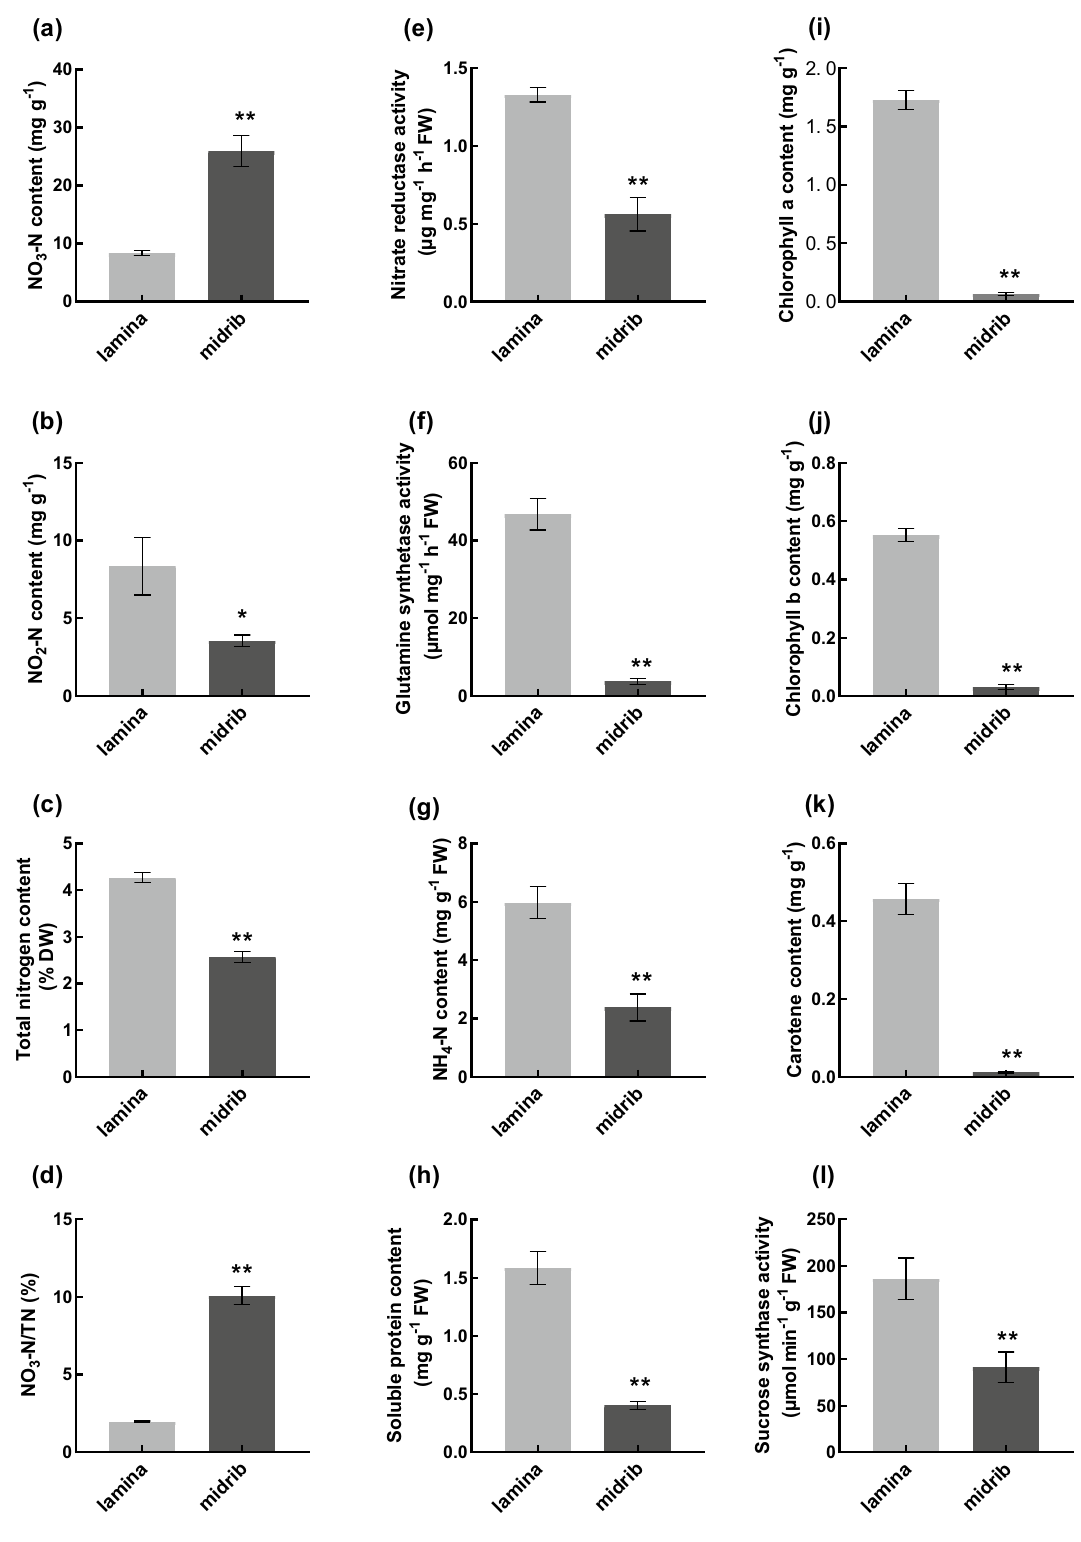
Figure 1. ( a ) NO 3 -N content; ( b ) NO 2 -N content; ( c ) total nitrogen content; ( d ) NO 3 -N/TN; ( e ) nitrate reductase activity; ( f ) glutamine synthetase activity; ( g ) NH 4 -N content; ( h ) soluble protein content; (i) chlorophyll a; ( j ) chlorophyll b; ( k ) carotene content; ( l ) sucrose synthetase. Symbols ** and *indicates that the significant differences between lamina and midrib at 0.01 and